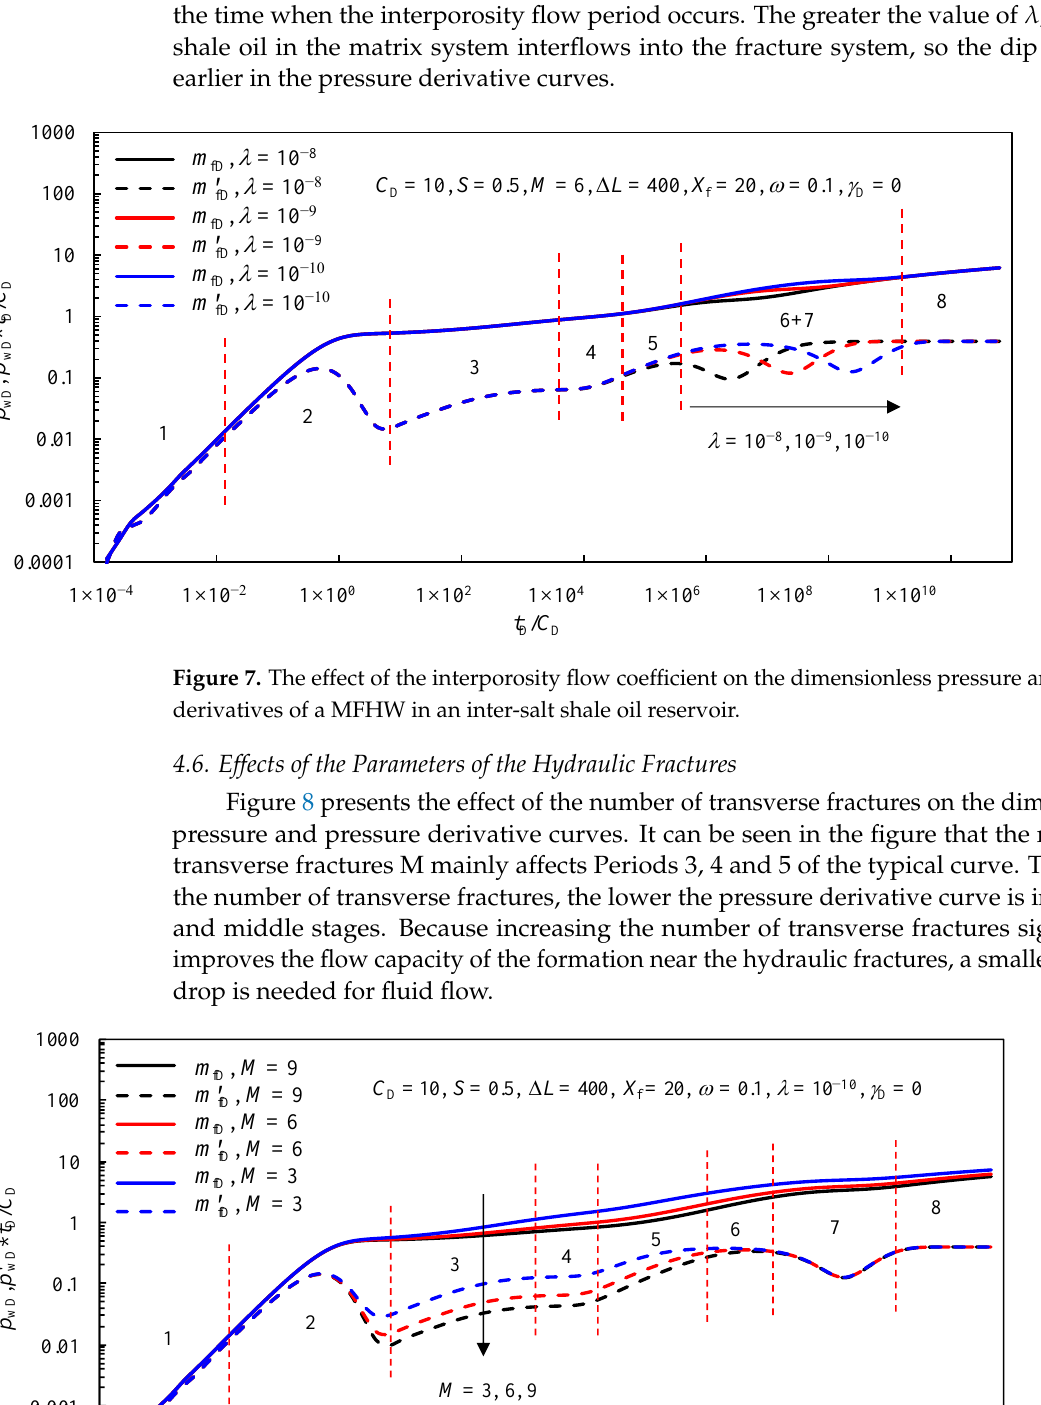
Figure 6. The effect of the storativity ratio on the dimensionless pressure and pressure derivatives of a MFHW in an inter-salt shale oil reservoir.